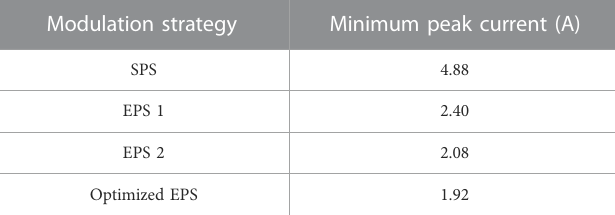
TABLE 2 The lowest current stress with all semiconductors ZVS. Modulation